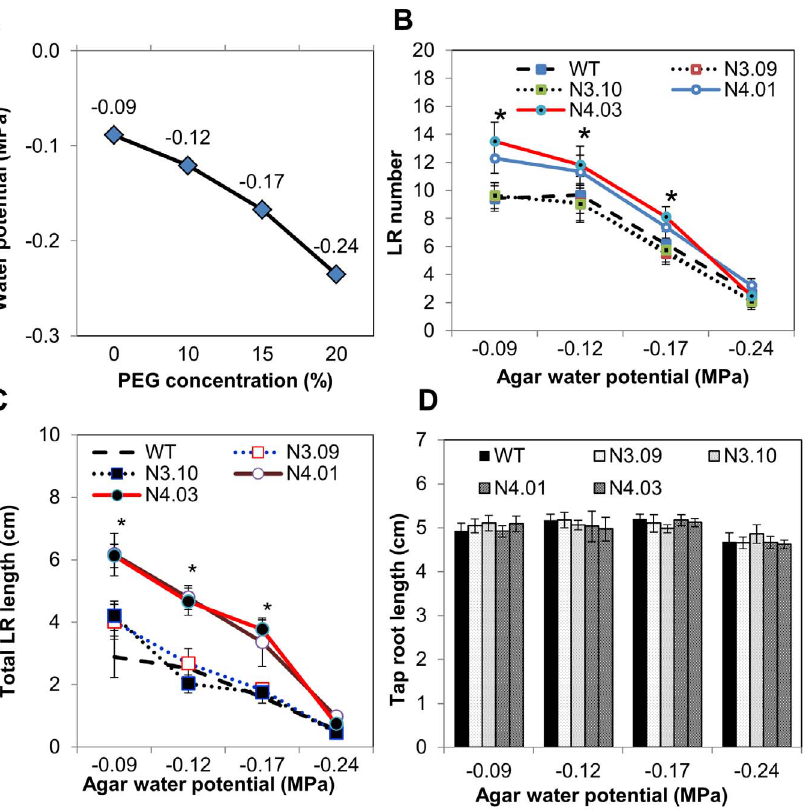
Figure 4. Lateral root numbers, lateral root length and primary root length of transgenic Arabidopsis plants overexpressing GmNAC003 and GmNAC004 in response to mild water stress. (A) Water potentials of PEG-diffused agar plates. Water potentials were measured at the end of the experiment, 8 days from the date of stress exposure. (B) Lateral root number, (C) total lateral root length, and (D) primary root length of transgenic plants. Transgenic GmNAC003 (events N3.09 and N3.10), GmNAC004 (events N4.01 and N4.03), and WT Arabidopsis lines were grown in nutrient agar plates diffused with different concentrations of PEG. The transgenic plants were at the T4 generation and homozygous for the transgenes. Data were recorded at 12 days after sowing (or 8 days of stress exposure). (*) denotes significant difference at 95% confidence level using Duncan’s multiple range test from six replications. Error bars are standard errors of the means from 6 replications.